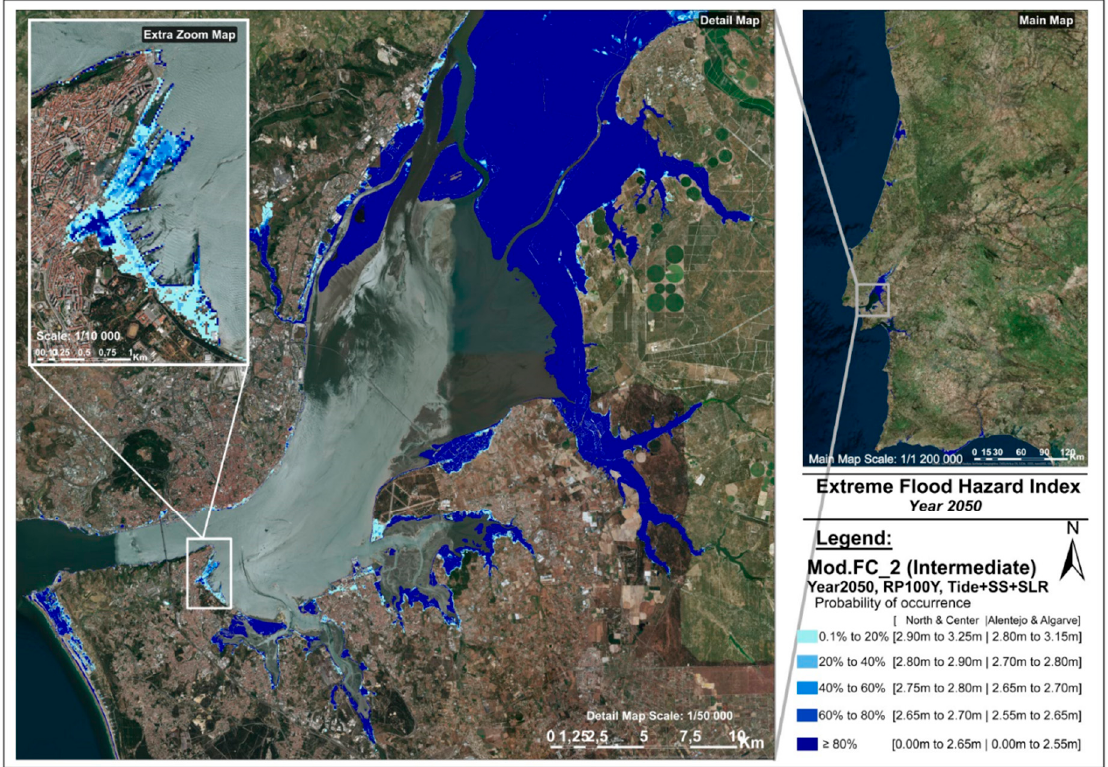
Figure 8. Portuguese coastal flooding extreme scenarios for 2050 SLR and 100-year RP, within a zoom image of the Tagus Estuary.